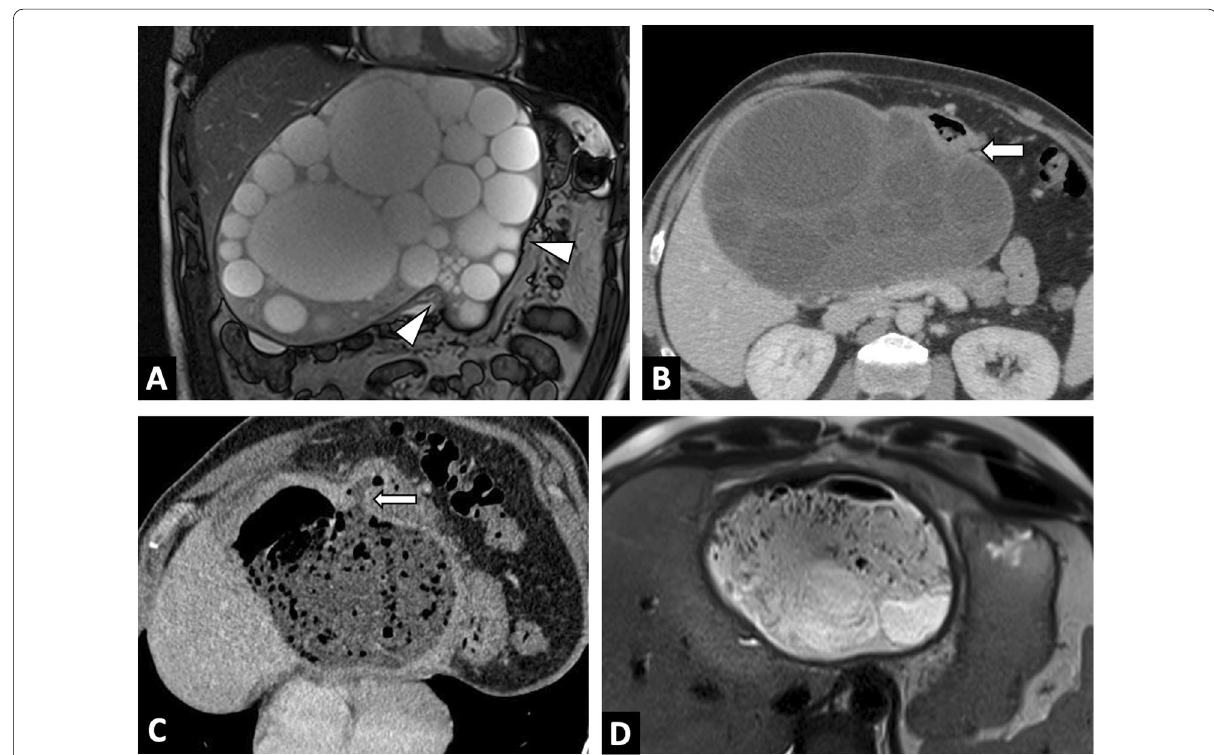
Fig. 18 Large cystic echinococcosis lesion of the left liver at CE3b stage discovered during an investigation of abdominal pain. A T2‑weighted MR image in the coronal plane: loss of continuity of the cyst wall (arrowheads) in contact with the gastric antrum. B CT image in the axial plane obtained during the portal phase of enhancement: close contact between the cyst wall and the gastric antrum (arrow). C CT image in the axial plane obtained during the portal phase in a context of fever and abdominal pain 3 months after the start of anti‑parasitic treatment. Appearance of digestive content and air‑fluid level within the CE lesion. Direct communication between the cyst and the gastric antrum (arrow). D Same lesion in T2‑weighted MR image in the axial plane. Note the emptying of most daughter cysts, a sign of evacuation in the digestive